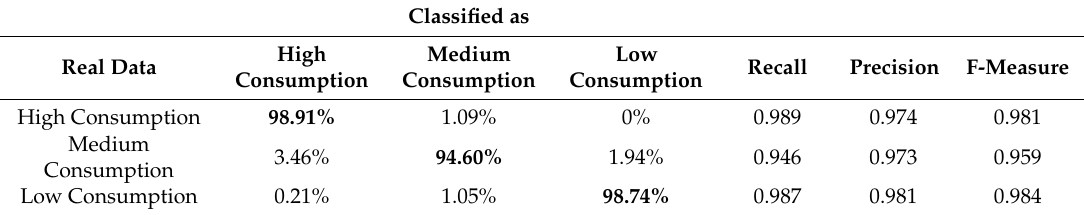
Table 4. Detailed classification results of CNN.